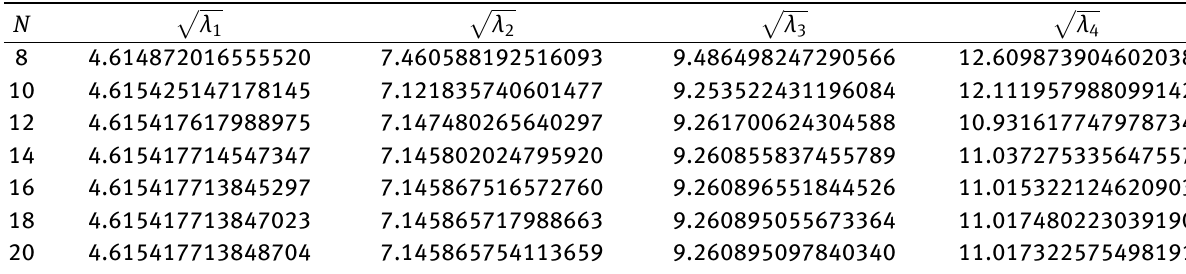
(︁ √ )︁ for CC case for different grid points λ